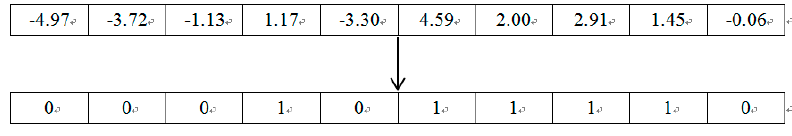
Figure 1. The example of the dichotomy encoding scheme.